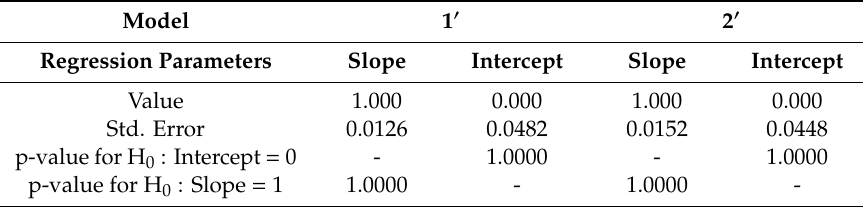
Table 3. Parameters for the testing of the readjusted model linear regressions.